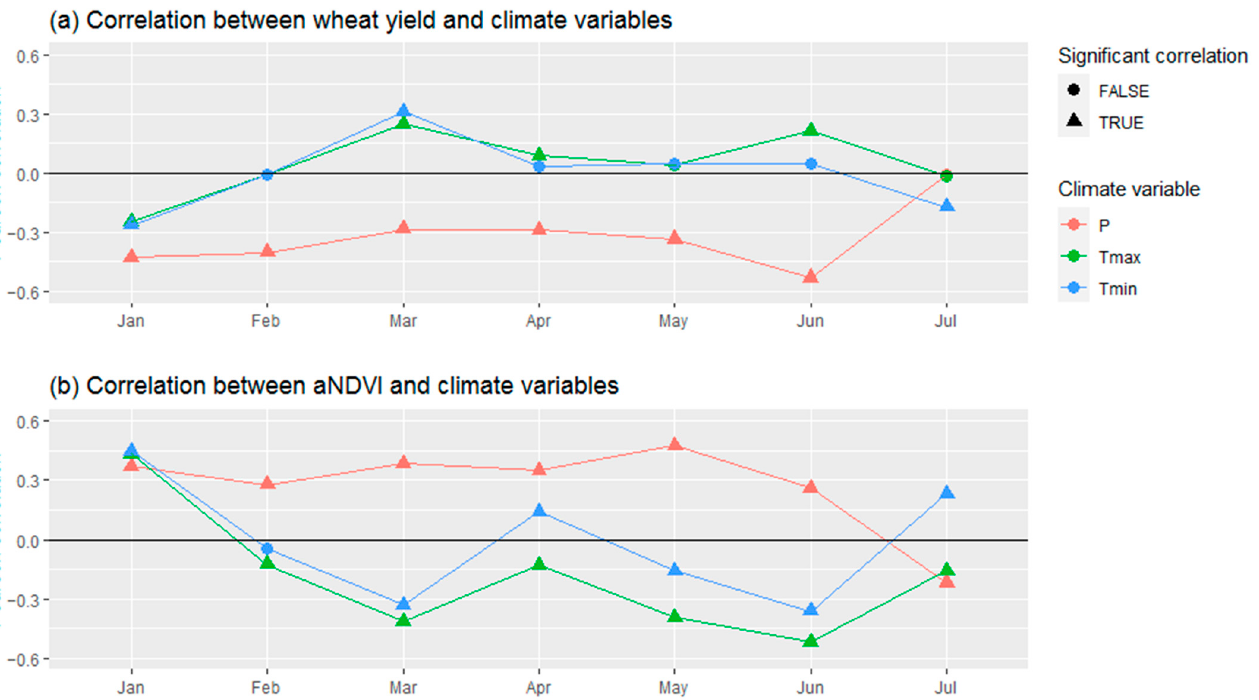
Figure 7. ( a ) Pearson correlation between winter wheat yield and monthly precipitation (P), minimum temperature (Tmin) and maximum temperature (Tmax) for the months from January to July); ( b ) Pearson correlation between aNDVI and monthly precipitation (P), minimum temperature (Tmin) and maximum temperature (Tmax) for the months from January to July; ( c ) Pearson correlation between maxNDVI and monthly precipitation (P), minimum temperature (Tmin) and max- imum temperature (Tmax) for the months from January to July. The months from January to July are indicated by the first three letters of each month. Significant correlation values (i.e., p -value < 0.01) and non-significant correlation values (i.e., p -value > 0.01) are indicated with triangles and circles, respectively. The pattern in correlation values between monthly precipitation, minimum and max- imum temperature and aNDVI was dissimilar to the correlation pattern observed between winter wheat yield and the considered monthly weather variables (Figure 7a,b). This in- dicates that aNDVI was influenced in another way by the considered weather variables. However, for maxNDVI, a similar correlation pattern between monthly weather variables and winter wheat yield was observed (Figure 7a,c). Similar to winter wheat yield, maxNDVI was negatively correlated with precipitation in June, January and February. In addition, maxNDVI was positively correlated with minimum and maximum temperature in March and maximum temperature in June. These were also the months where a positive correlation between winter wheat yield and minimum and maximum temperatures was observed.